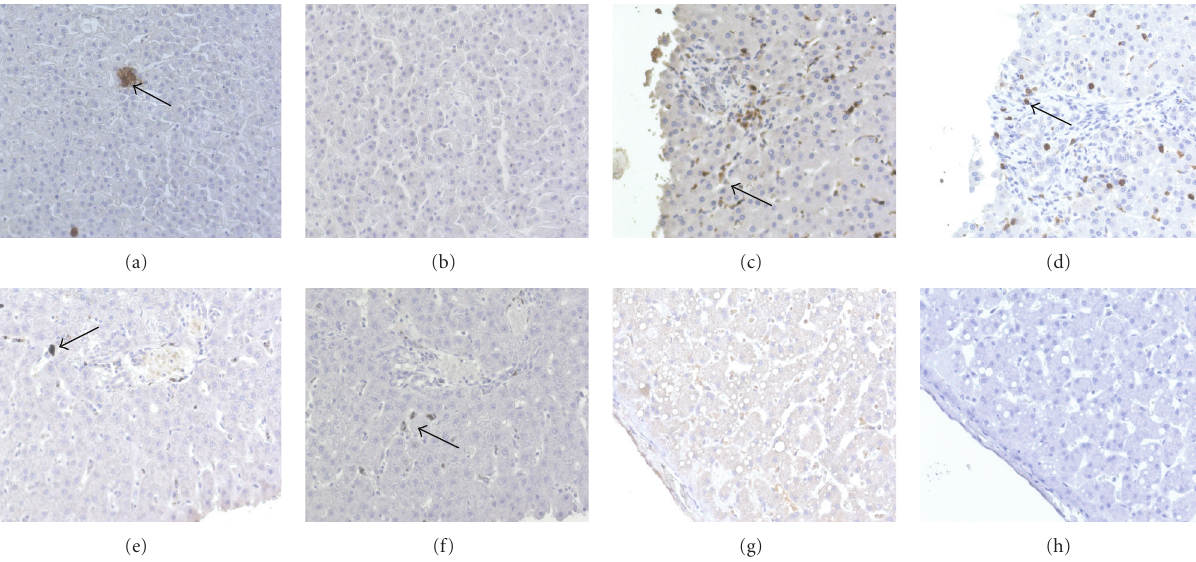
Figure 5: Para ffi n-embedded liver sections from islet recipients stained for insulin (a, c, e, g) and CD3 (b, d, f, h), 20x magnification. Animals pre-treated with exenatide showed insulin-positive cells (a) with little evidence of CD3 positive cells (b) (day 435 posttransplant). Animals receiving exenatide after transplant only showed evidence of islet destruction with insulin accumulation in the Kup ff er cells of the liver (c). CD3 positivity was also noted throughout the liver in animals treated with exenatide after transplant only (d) (day 10 posttransplant). Minimal evidence for insulin positive islet cells was found in the liver of animals treated with conventional immunosuppression while some residual staining was noted in Kup ff er cells of these animals (e). Some CD3 positive cells were also noted in these grafts (f) (day 90 posttransplant). No insulin positivity (g) or CD3 positive cells (h) were found in the livers of untreated animals (day 10